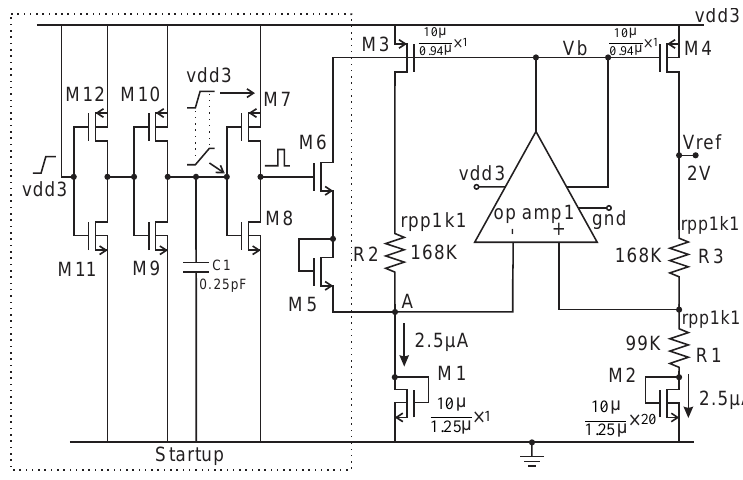
Figure 8. Schematic of bandgap reference (BGR) for HV LDO. R2 is added to reduce the current mismatch through M3 and M4.